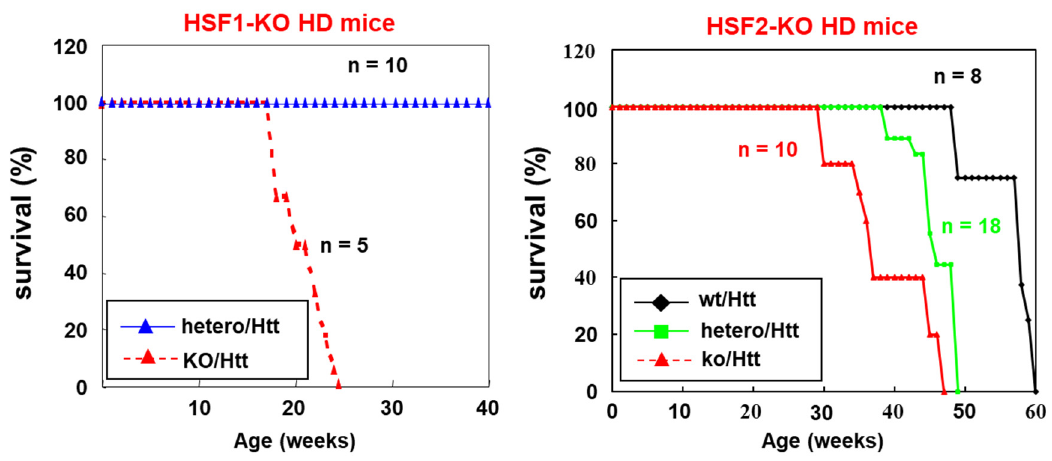
Figure 1. Deficiency of HSF1 and HSF2 causes the shortening of life span in Huntington’s disease (HD) mice. HSF1 -KO HD mice died within 24 weeks but HSF1 -hetero HD mice survive more than 40 weeks ( left ). HSF2 -KO HD and HSF2 -hetero HD mice died within 46 and 48 weeks ( right ), respectively. But HSF2 -WT HD mice survived until 60 weeks.